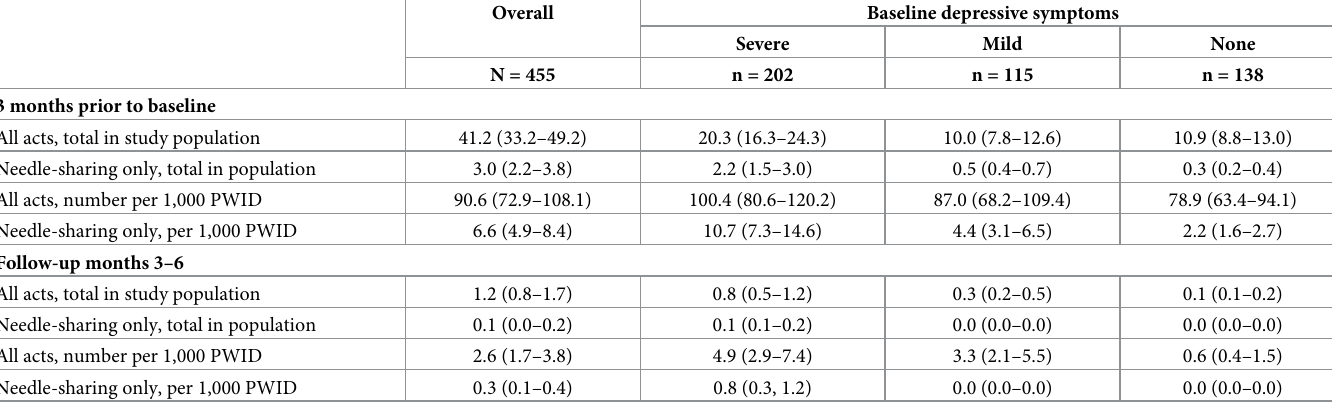
Table 2. Total modeled secondary transmission events in study population (N = 455) and expected number of transmission events per 1,000 PWID living with HIV, overall and in each depressive symptom